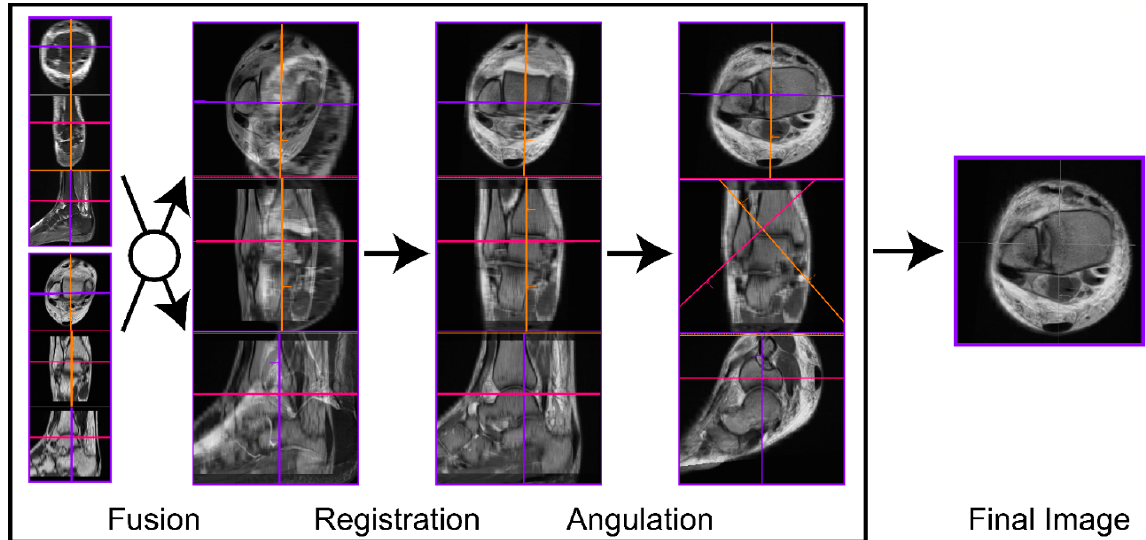
Figure 1. Oblique fusion reconstruction (OFR) was performed utilizing 3D postprocessing software. The transversal PDw and the sagittal PDw FS were first fused into one dataset, and then the two differently oriented image series were registered to create perfectly concordant images. From there, aligned in a 45 ◦ coronal angle to the tibial plafond, the oblique fusion images were reconstructed. The colored lines show the orientation of the displayed images in